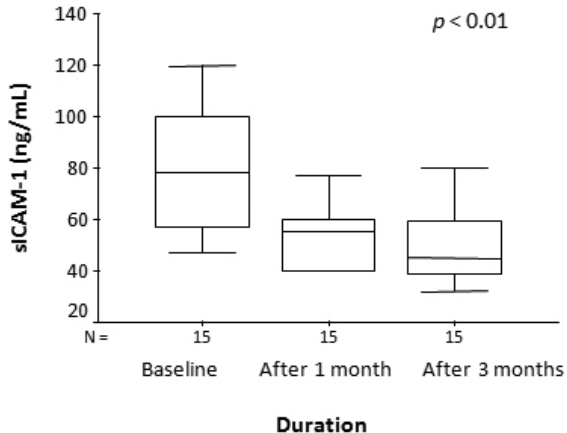
Figure 1. Comparison between sICAM values in responders at different times of the study.